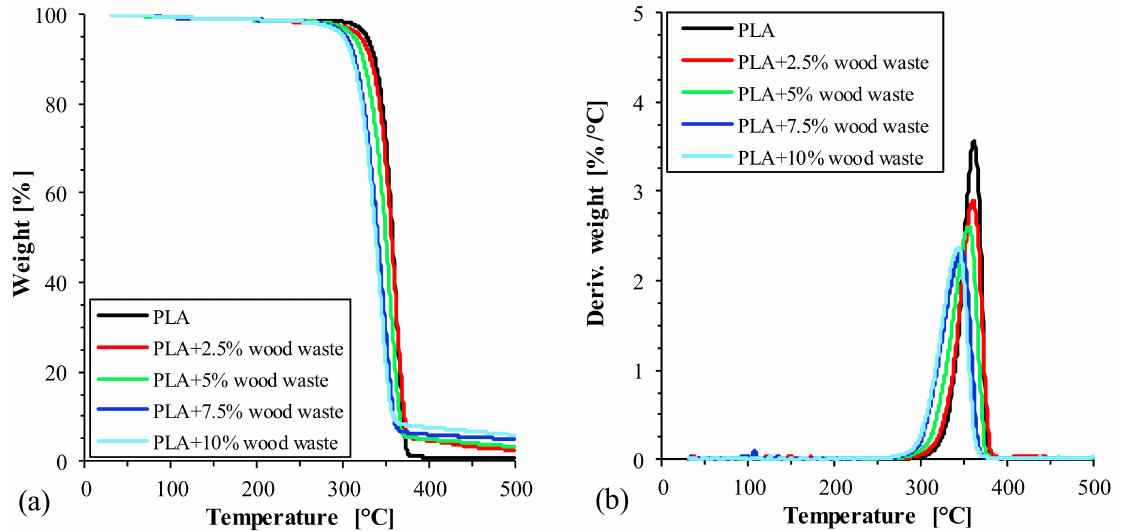
Figure 2. TGA ( a ) and DTG ( b ) curves for PLA biocomposites, respectively. Using 5% weight loss (T 5 ) as the onset of the main degradation step, the temperature was 327 ◦ C for the bare PLA but decreased to 320 ◦ C when 2.5 wt.% wood waste was added. When the wood waste loading was increased even further (5, 7.5, and 10% wt.%), the composites’ onset degradation temperature decreased to 312 ◦ C, 304 ◦ C, and 300 ◦ C, respectively. Similarly, with increased wood waste content, the temperatures for 25%, 50%, and 75% weight loss and the temperatures corresponding to the highest decomposition rate also decreased considerably. Previous studies reported similar trends with various natural fiber-filled PLA composites